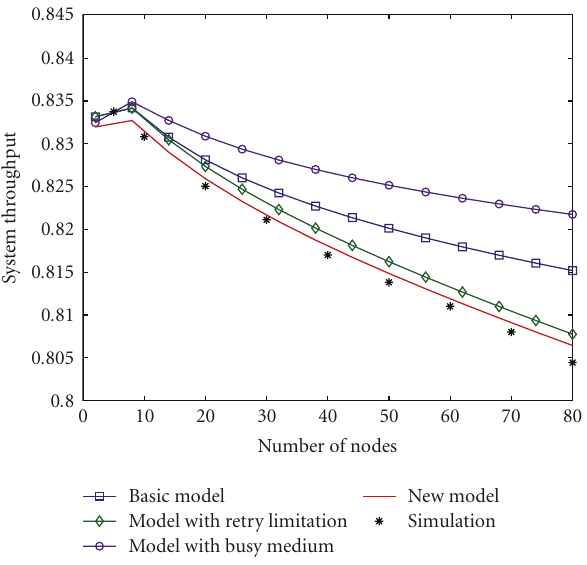
Figure 8: Analysis versus simulation (saturated). Table 2: System parameters for MAC and DSSS PHY